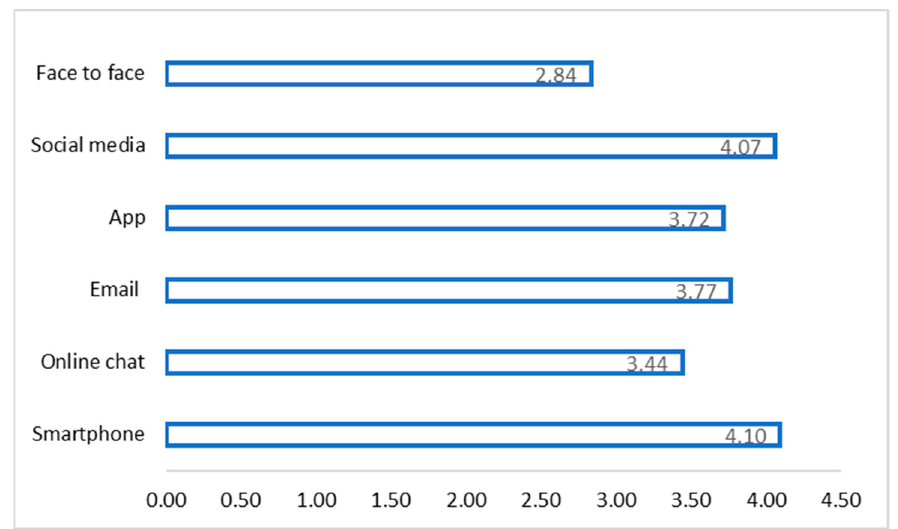
Figure 2. Communication channels used with tourism companies (Likert scale from 1 to 5).